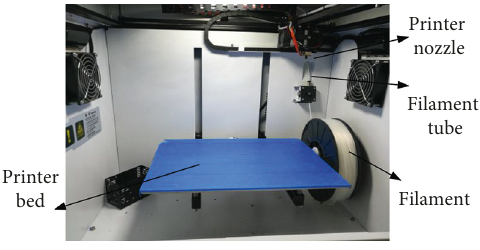
Figure 2: JGAURORA 3D